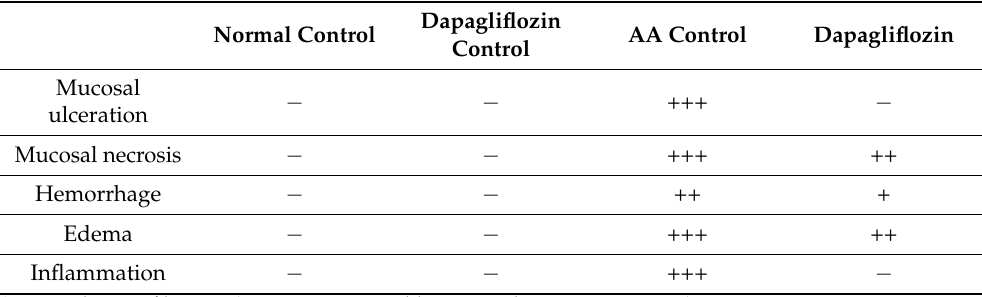
Table 1. Effect of DAPA on AA-induced change in count of inflammatory cells for H&E. Dapagliflozin AA Control Normal Control Control